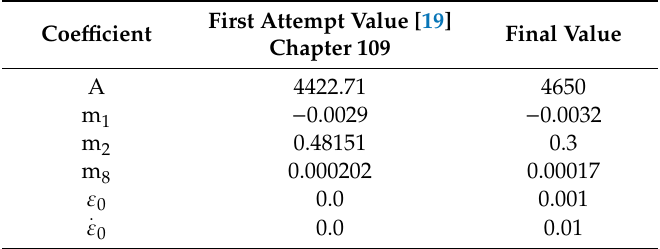
Table 1. Coe ffi cients of first attempt and final value of the same coe ffi cients for the rheological model of the EN 1.4512 steel in Equation (1).